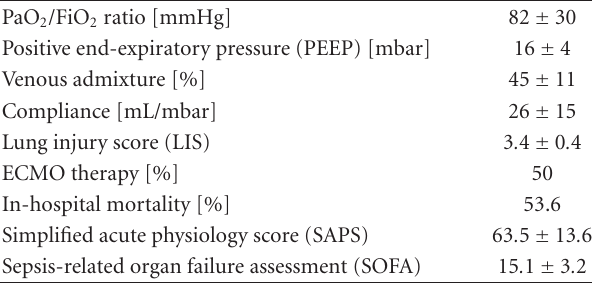
Table 1: Clinical characteristics of ARDS